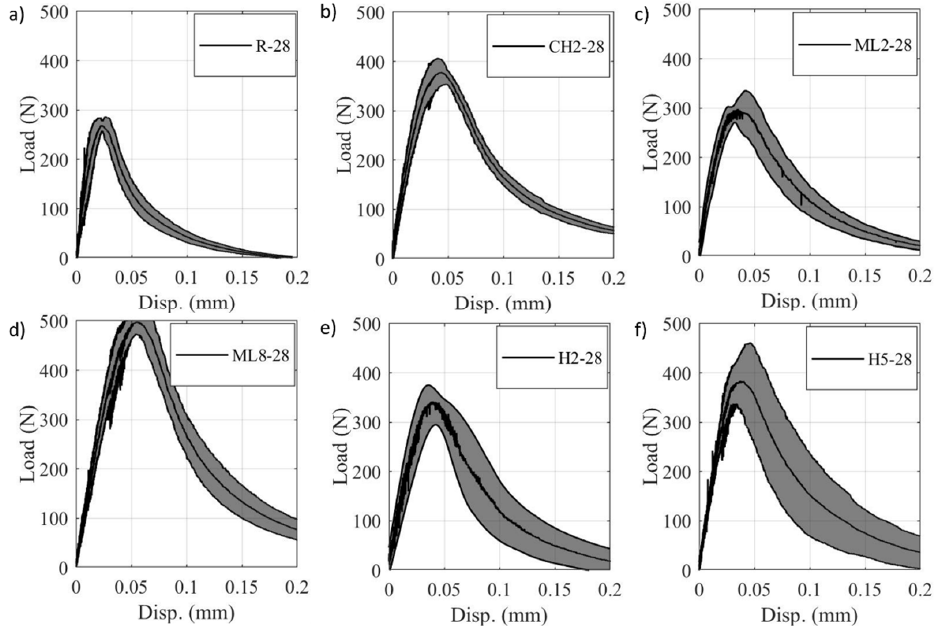
Figure 11. Comparison of notched bending mean and variance response for the ( a ) reference and carbon fiber reinforced cementitious composite mixes (( b ) CH2, ( c ) ML2, ( d ) ML8, ( e ) H2, and ( f ) H5) at 28 days of age. Each graph represents the mean of five tested samples.